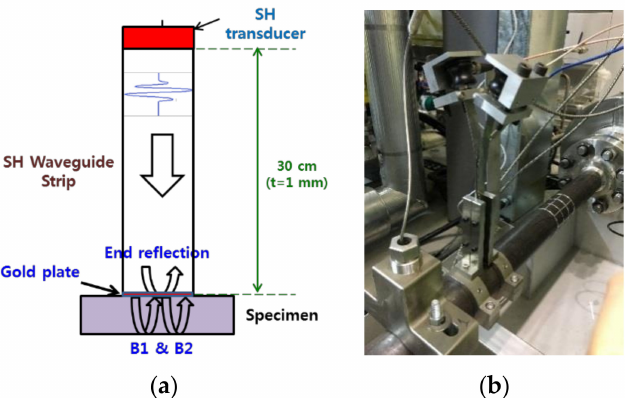
Figure 2. ( a ) Conceptual diagram of a pair of waveguide strips for high temperature thickness monitoring; ( b ) installed waveguide system for thickness monitoring on a